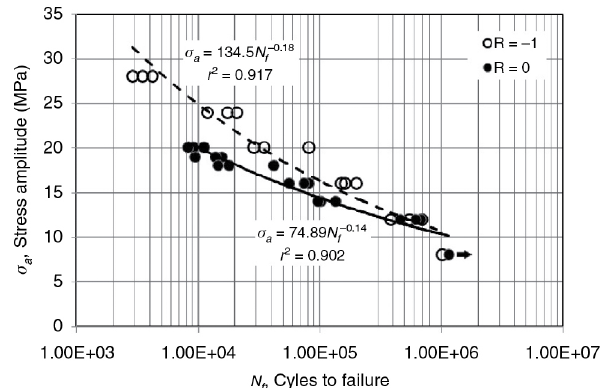
Figure 6: S-N curves for R = 0, − 1 of the friction stir welded T-joint. The stress amplitude is defined as: